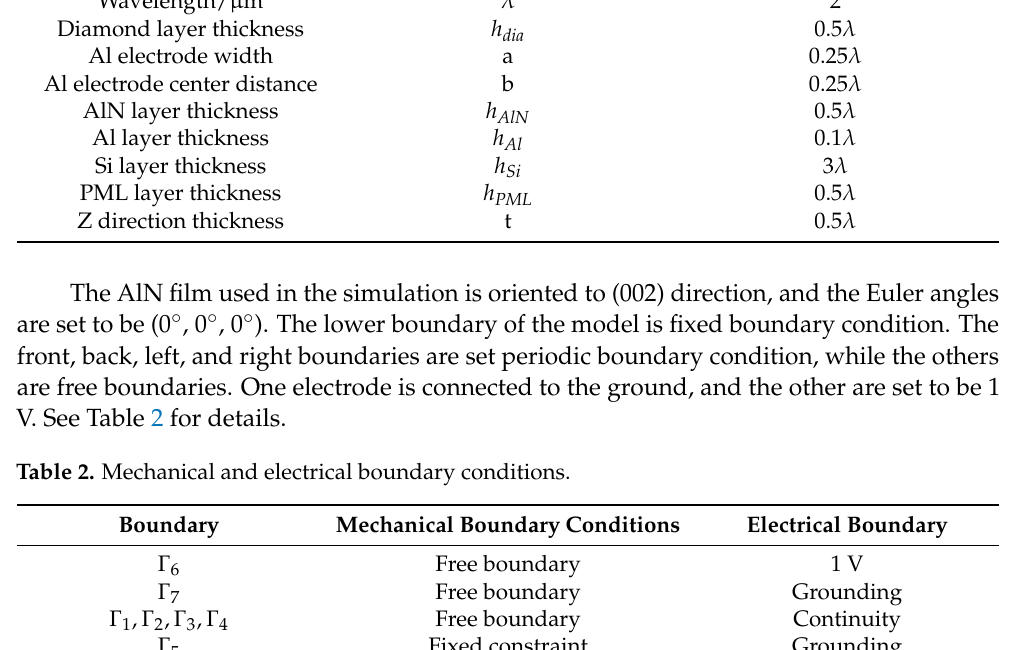
Table 1. Geometry characters of the FEM model.